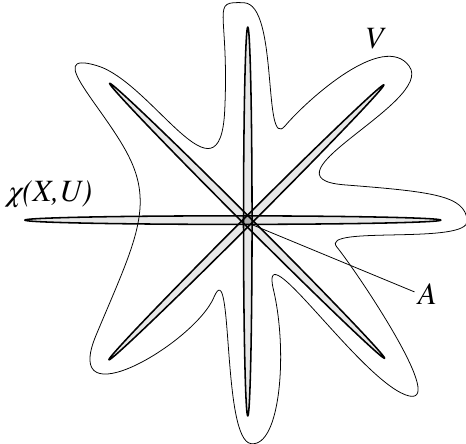
Figure 2: In the second case, given A and X , the number of candidates for V is small because V must include an unusually large number of sets of the form χ ( y , U ) \ χ ( X , U )